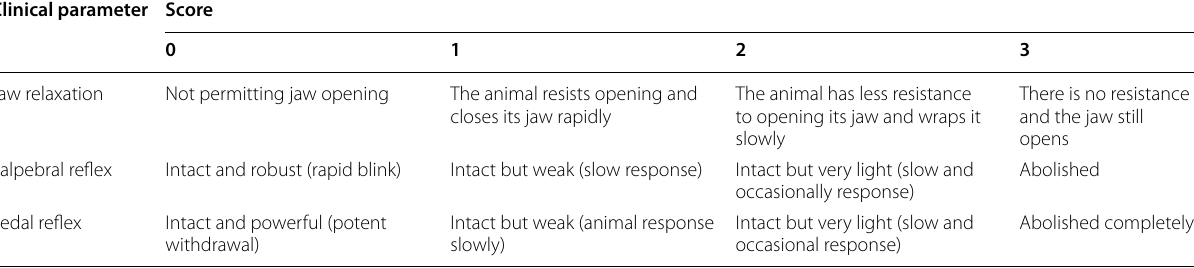
Table 1 Numeric scoring system applied to estimate several reflexes Clinical parameter